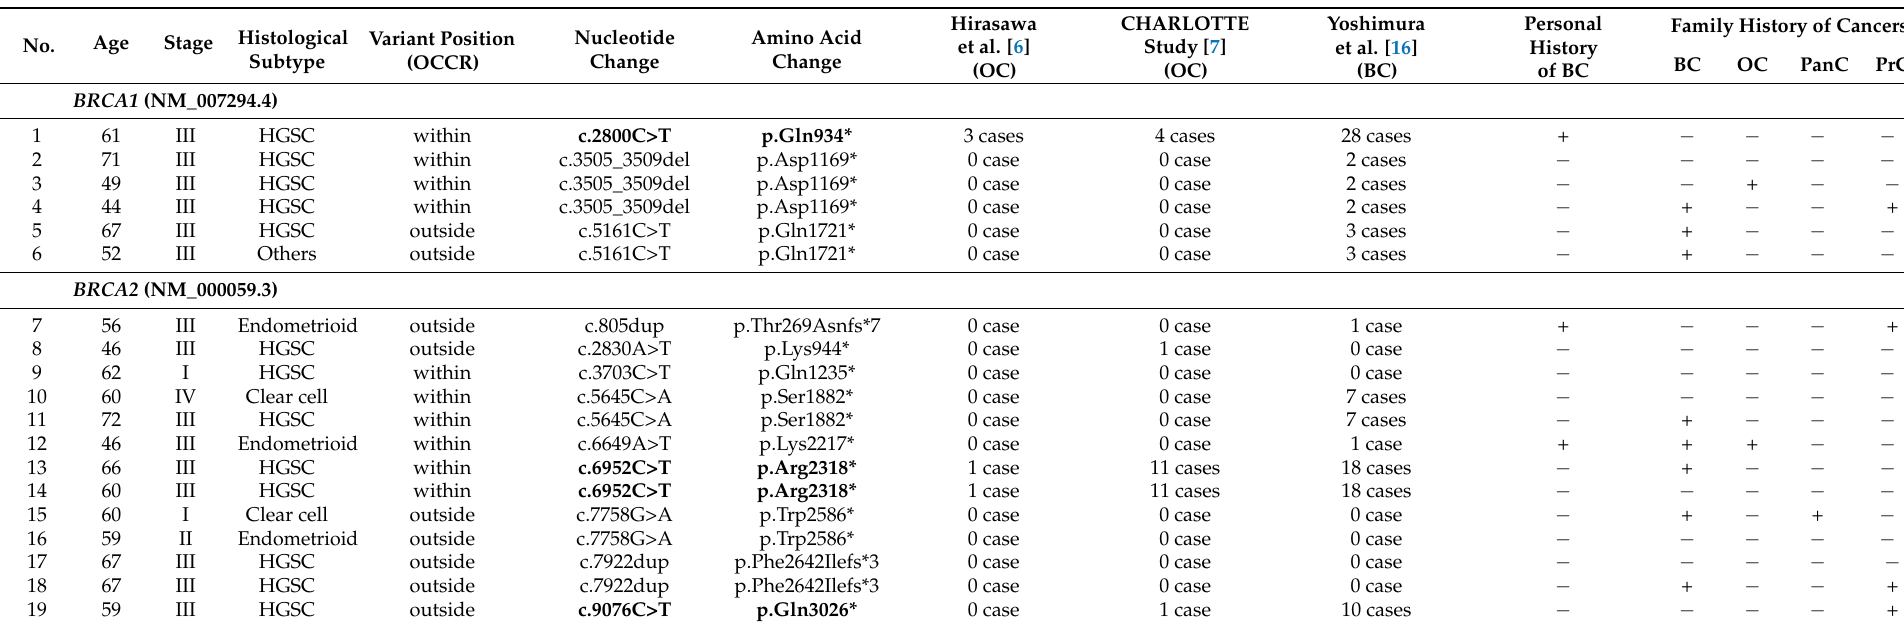
Table 2. List of g BRCA1/2 pathogenic variants and clinicopathological features of patients with ovarian cancer (OC) with these